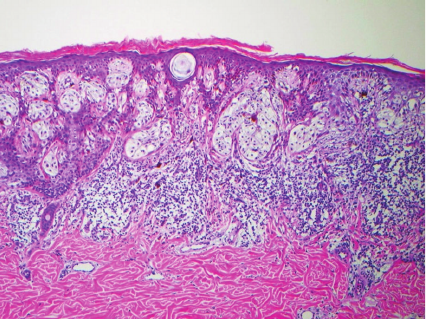
Figure 9: Histopathology for Figure 5(a), invasive melanoma 0.44 mm